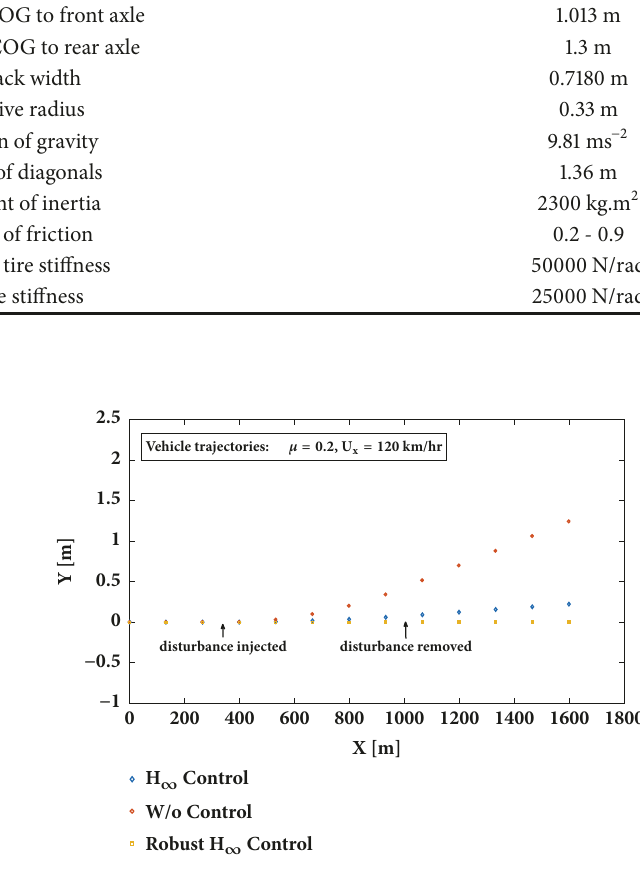
Figure 3: Vehicle trajectories: 𝜇 = 0 .2; vehicle speed: 120km /